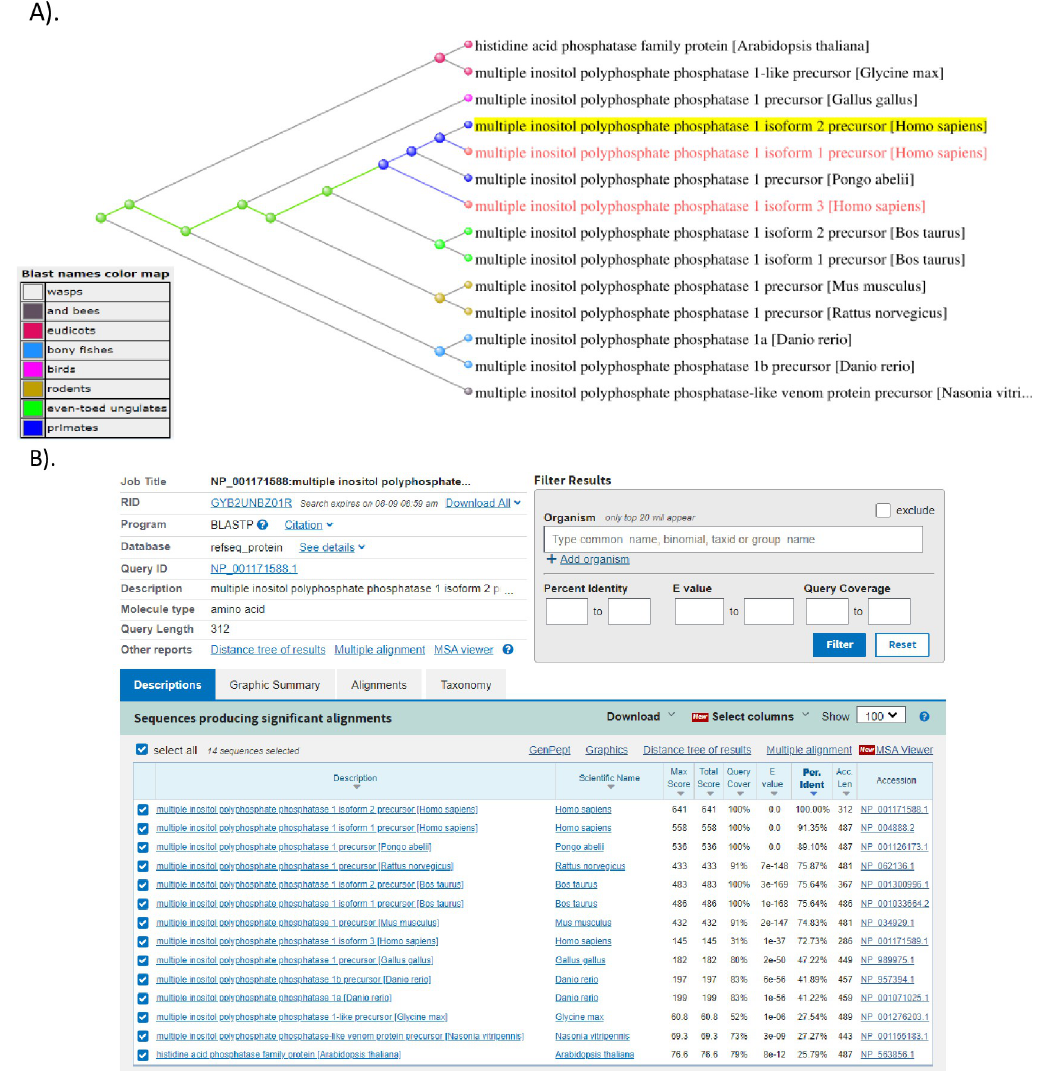
Fig 4. hMinpp1 isoform-2 (NP_001171588.1) (highlighted yellow) related amino acid sequences across species A). A rooted slanted cladogram B). BLASTP was used to compute the hMinpp1 isoform-2 amino acid sequence in a pair-wise alignment against the curated NCBI refseq_protein database to construct the above-mentioned distance-based cladogram. The higher pairing sequences were included in the tree, displaying homology across taxonomic species—percent identity ranged: 25.79% to 100%. The search was limited to records that exclude models (XM/XP). hMinpp1 isoform-1: NP_004888.2. hMinpp1 isoform-3: